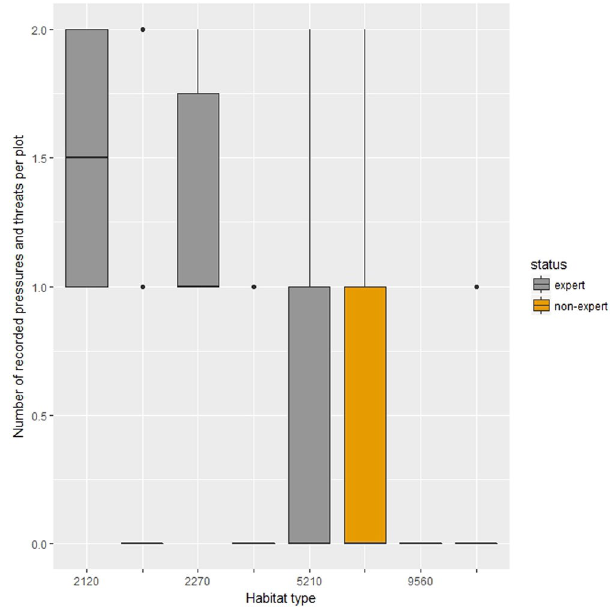
Figure 3. Boxplots of the number of pressures and threats recorded per sampling area for the different habitat types. With grey colour is the records made by experts and with orange colour is the records made by non- experts. Habitat codes, box and whiskers as in Fig.